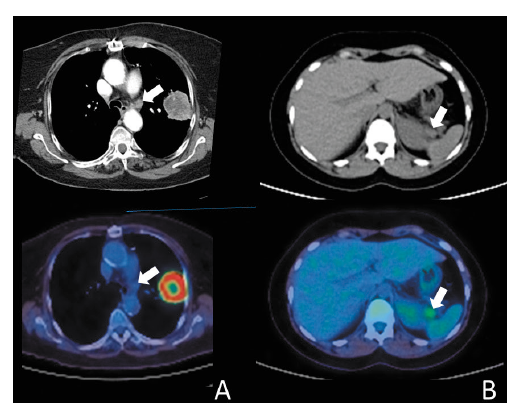
Fig. 2. Patient with a mass on the greater curve of the stomach on gastroscopy. Histology showed a NET. Whole body somatostatin-receptor imaging with [Tc-99m] Tekrotyd shows disease restricted to the stomach lesion and a lymph node. These are shown on CT with calcification in the stomach lesion, as well as incidental liver and left kidney cysts.